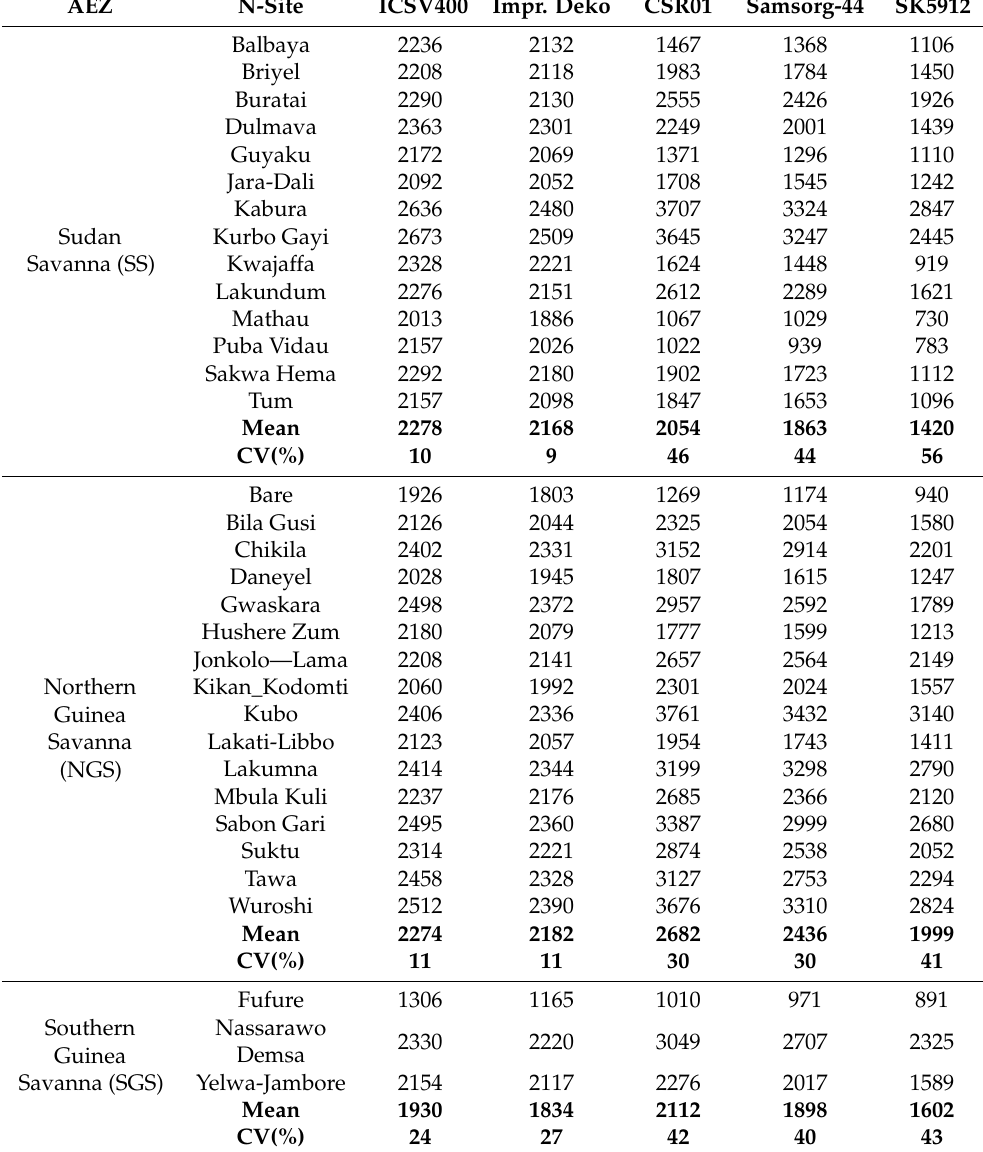
Table 10. Mean simulated grain yield (kgha − 1 ) for evaluating adapted sorghum cultivars across sites and AEZs based on increased yield